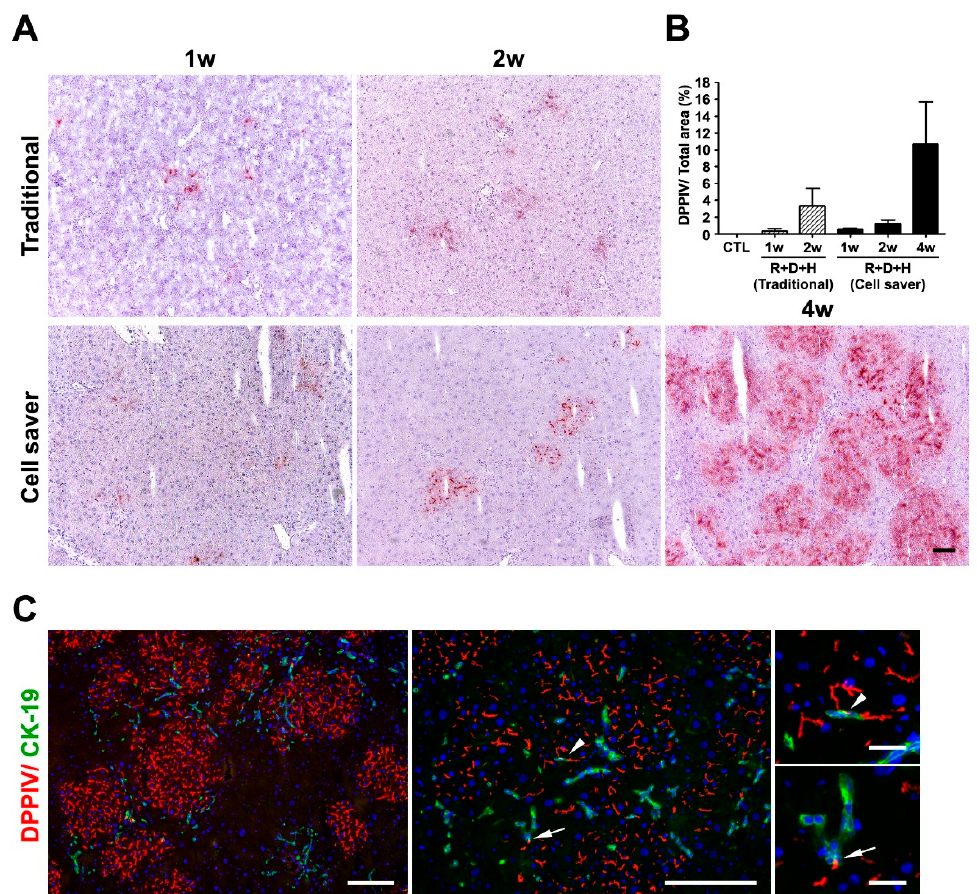
Figure 5. Engraftment and repopulation after hepatocyte transplantation. ( A ) DPPIV histochemical staining for donor hepatocytes showed that donor hepatocytes collected using the Cell Saver ® strategy can engraft and repopulate recipient liver well in 4 weeks. ( B ) Engraftment efficiency comparison between the traditional method and Cell Saver ® strategy. ( C ) Repopulation of donor hepatocytes derived using the Cell Saver ® strategy 4 weeks after transplantation, identified using immunofluorescent staining of DPPIV. Small bile ductular cells were marked using CK-19. Close contact connection of donor hepatocytes and ductular proliferative cells are observed (arrow and arrowhead). R+D+H: retrorsine and D-galactosamine + hepatocyte transplantation. Scale bar: 100 μ m.